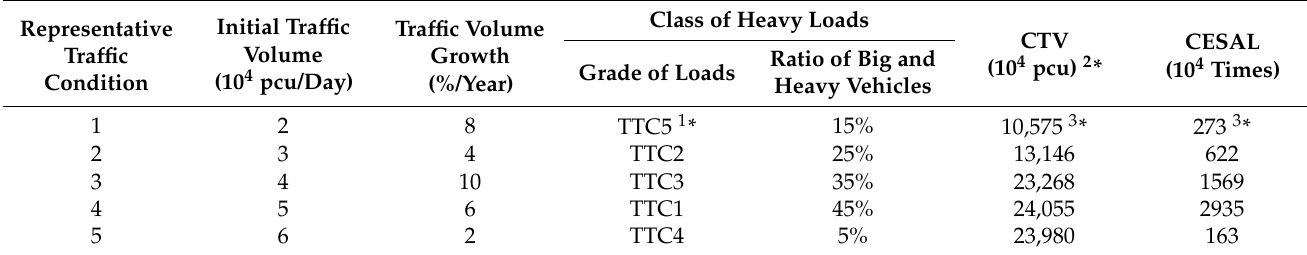
1 * TTC represents the distribution coefficient of big and heavy vehicles type [32]. 2 * CTV represents the cumulative traffic volume. 3 * CTV and CESAL of representative traffic conditions from 1 to 5 refer to the cumulative amount during the analysis period (10